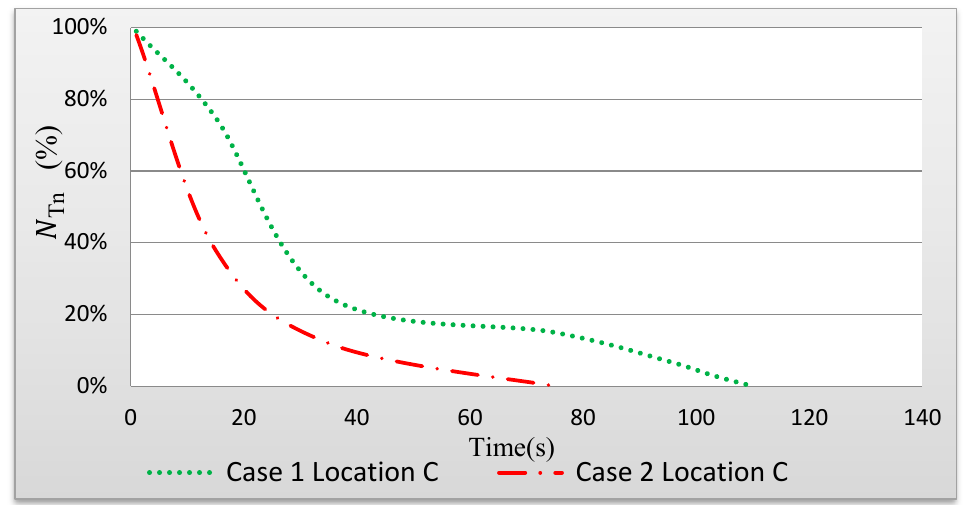
Figure 13. Time-dependent changes in the fraction of droplets remaining in the air ( N Tn ) in the area for Case 1 and Case 2.